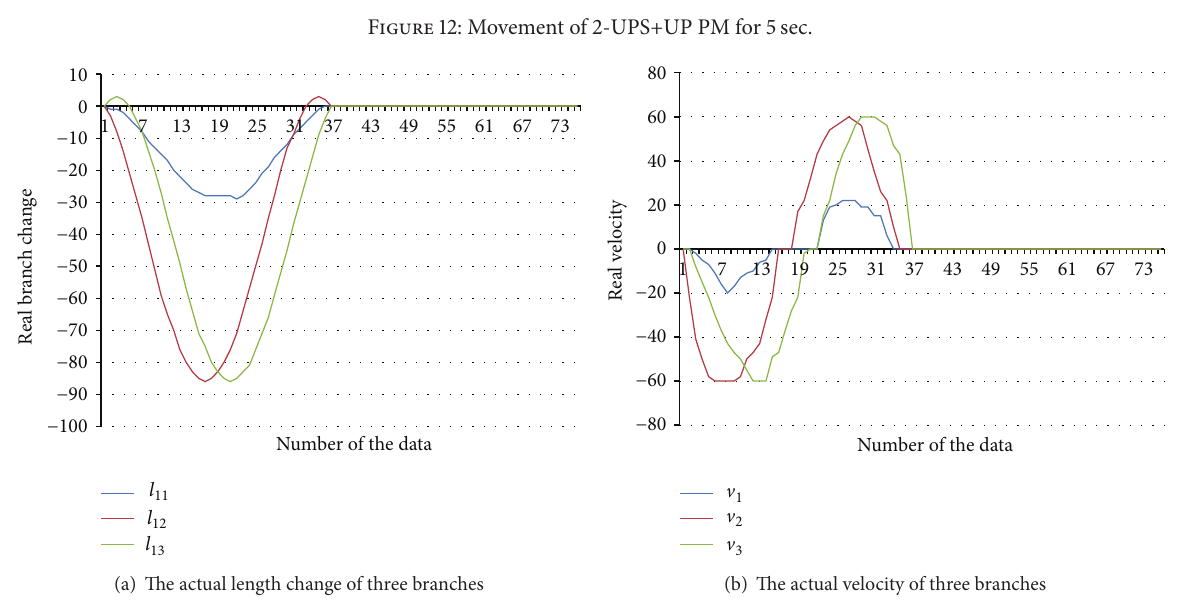
Figure 13: Real movement of three branches of the leg